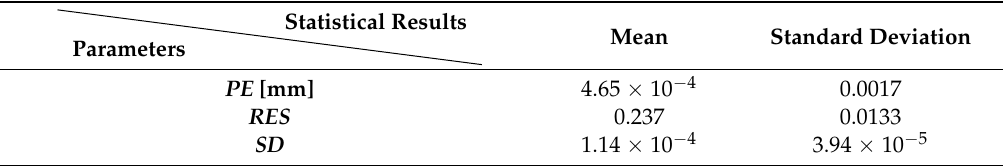
Table 1. Electrical capacitance tomography imaging accuracy evaluation results. PE —position error; RES —resolution; SD —shape